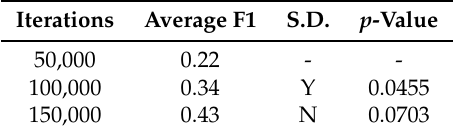
Table 11. ISFB Dataset—Training Iteration Performance.